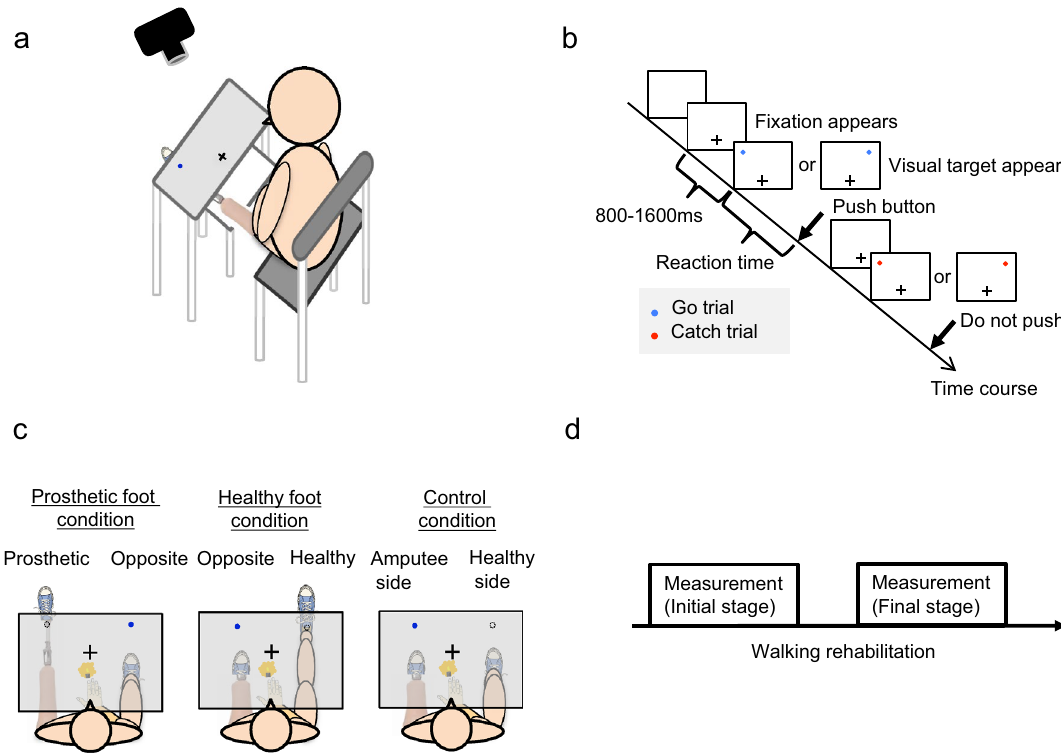
Figure 1. Experimental design. The figure demonstrates the experimental task and procedure in four panels. ( a ) Experimental environment: Patients sat in a chair in front of a rack in a quiet room and were required to respond to a visual target that appeared on either the prosthetic foot or on the opposite side from a projector attached to the rack. ( b ) Visual detection task: After the fixation point appeared, the visual target randomly appeared from 800 to 1600 ms on a white board. Patients were required to push the button only when a blue-filled circle appeared. ( c ) Experimental conditions: In the prosthetic foot condition, patients placed their prosthetic foot on a foot-stand. In the healthy foot condition, their healthy foot was placed on a foot-stand. In the control condition, neither the prosthetic foot nor the healthy foot were placed on a foot-stand. For patients with left lower limb amputation, in the prosthetic foot condition, the left prosthetic foot was placed on a foot- stand on the left side. ( d ) Procedure: The measurements were performed in two periods. The initial stage refers to the time at which one month had passed since patients began using the prosthetic foot and they were able to walk with the supervision of medical staff. The final stage is the time when they could walk